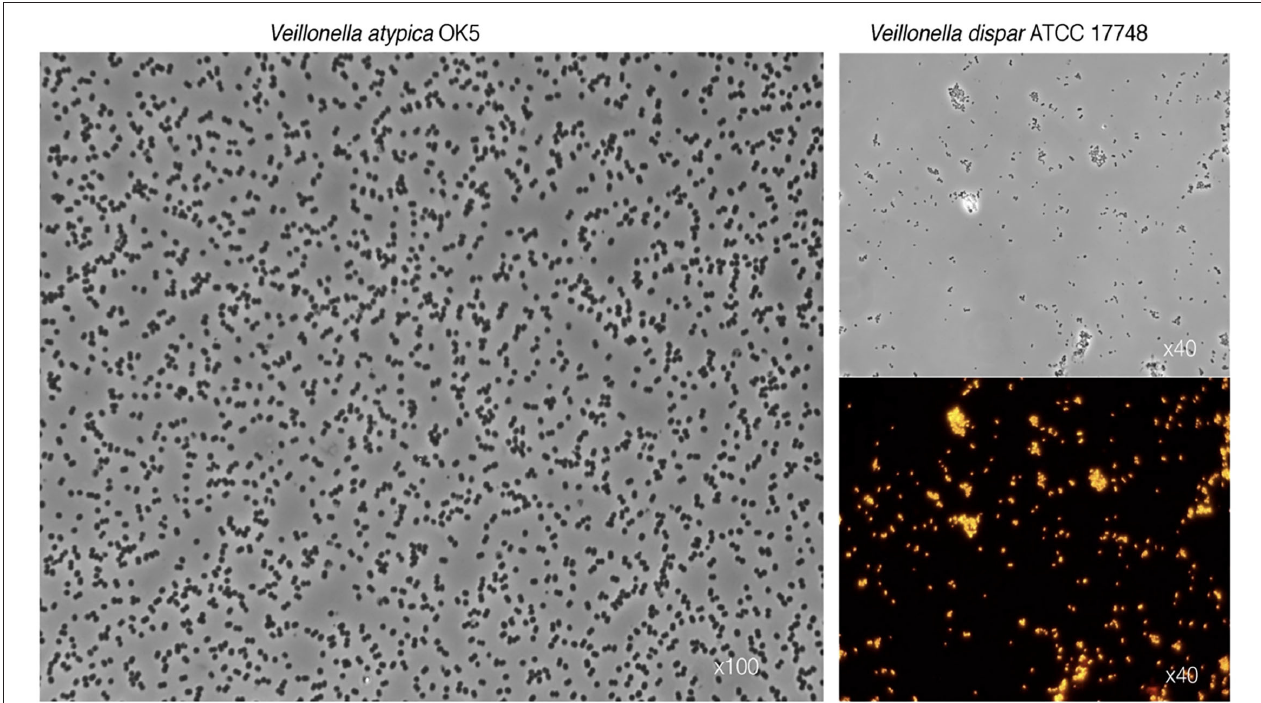
FIGURE 1 | Characteristic photomicrographs of two Veillonella species. Differential interference contrast (DIC) observations show the typical diplococcus phenotype for V. atypica (left panel) and V. dispar (top right panel) . Lower right panel depicts fluorescence in situ hybridization (FISH) of the same V. dispar cells using the 16S rRNA probe VEI217-Cy3 and epifluorescence microscopy